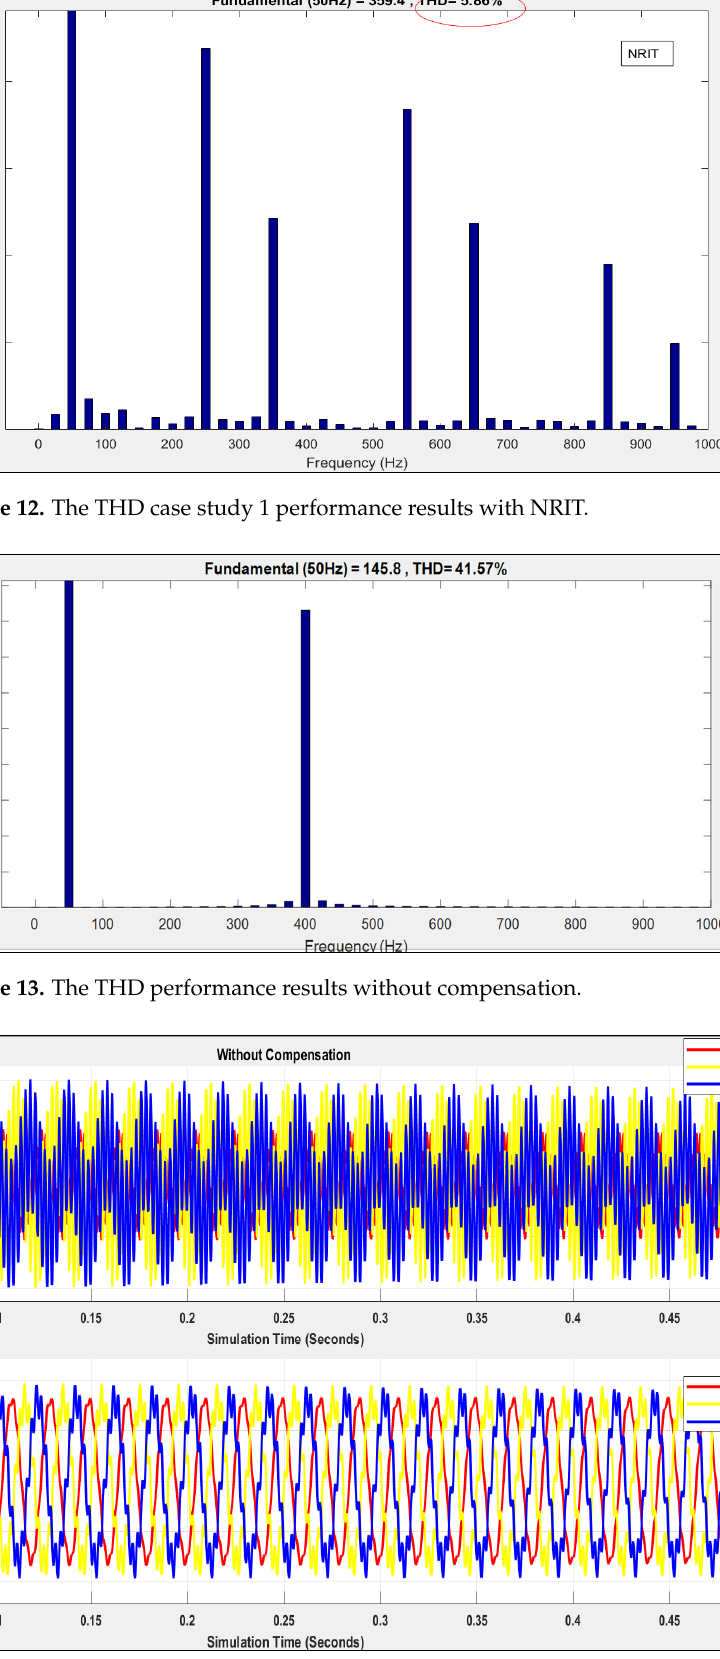
Figure 14. Three-phase grid voltages and current without